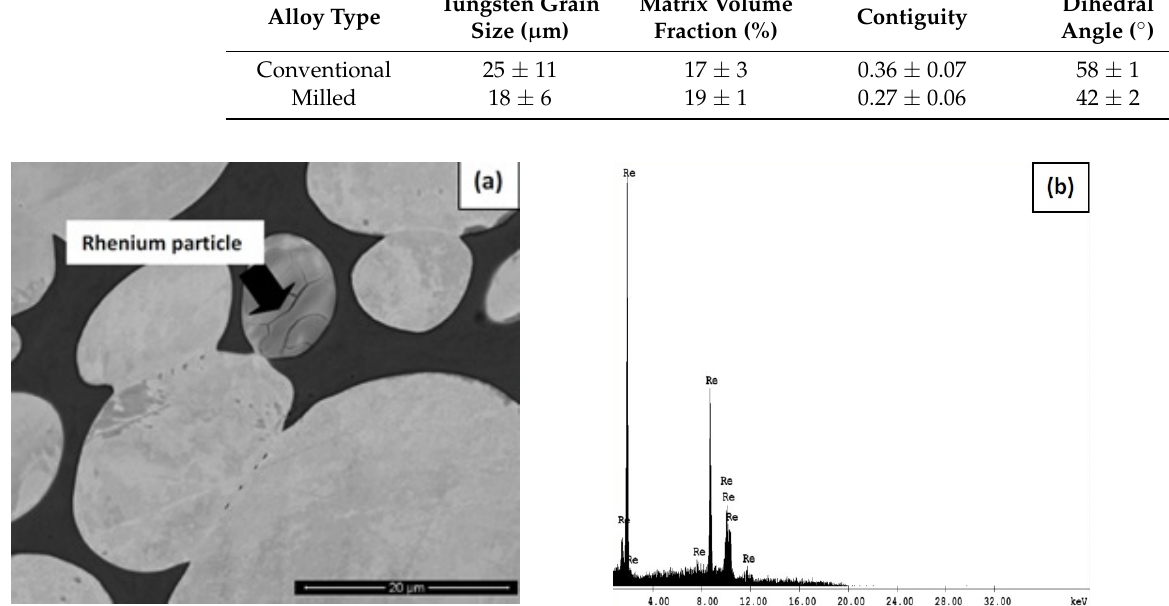
Figure 2. ( a ) SEM micrograph showing the presence of undissolved rhenium particles in the conventionally sintered alloy without milling and ( b ) Energy-Dispersive Spectroscopy pattern of rhenium (Re) particle [51]. Reproduced with permis- sion from Ravi Kiran et al., Journal of Alloys and Compounds; published by Elsevier, 2017